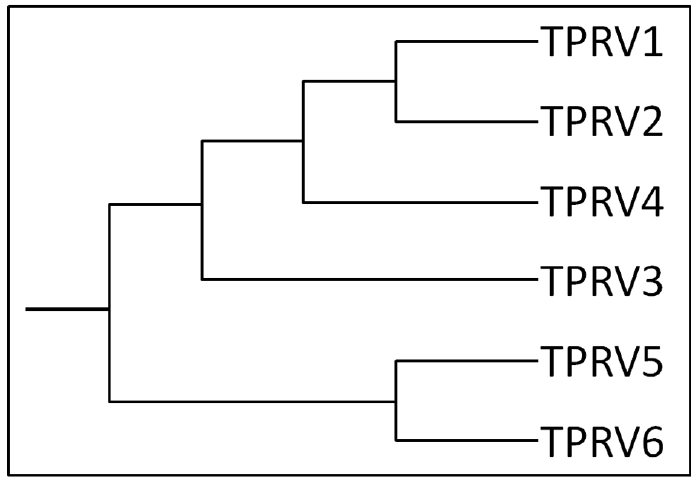
Figure 1. Human TRPV channel subfamily dendrogram. The schema shows a graphical phylogenetic reconstruction of the TRPV subfamily, created from the alignment and phylogenetic reconstruction obtained after using ClustalW.